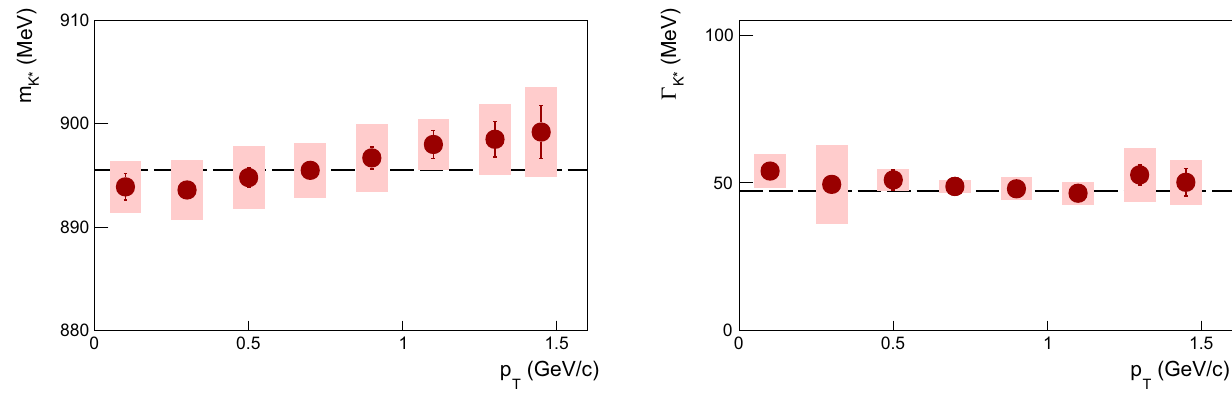
Fig. 8 The transverse momentum dependence of mass and width of K ∗ ( 892 ) 0 mesons fitted for 0 < y < 0 . 5. The numerical data are listed in Table 2. The horizontal lines represent PDG values m 0 = 895 . 55 MeV and (cid:4) 0 = 47 . 3 MeV [35]